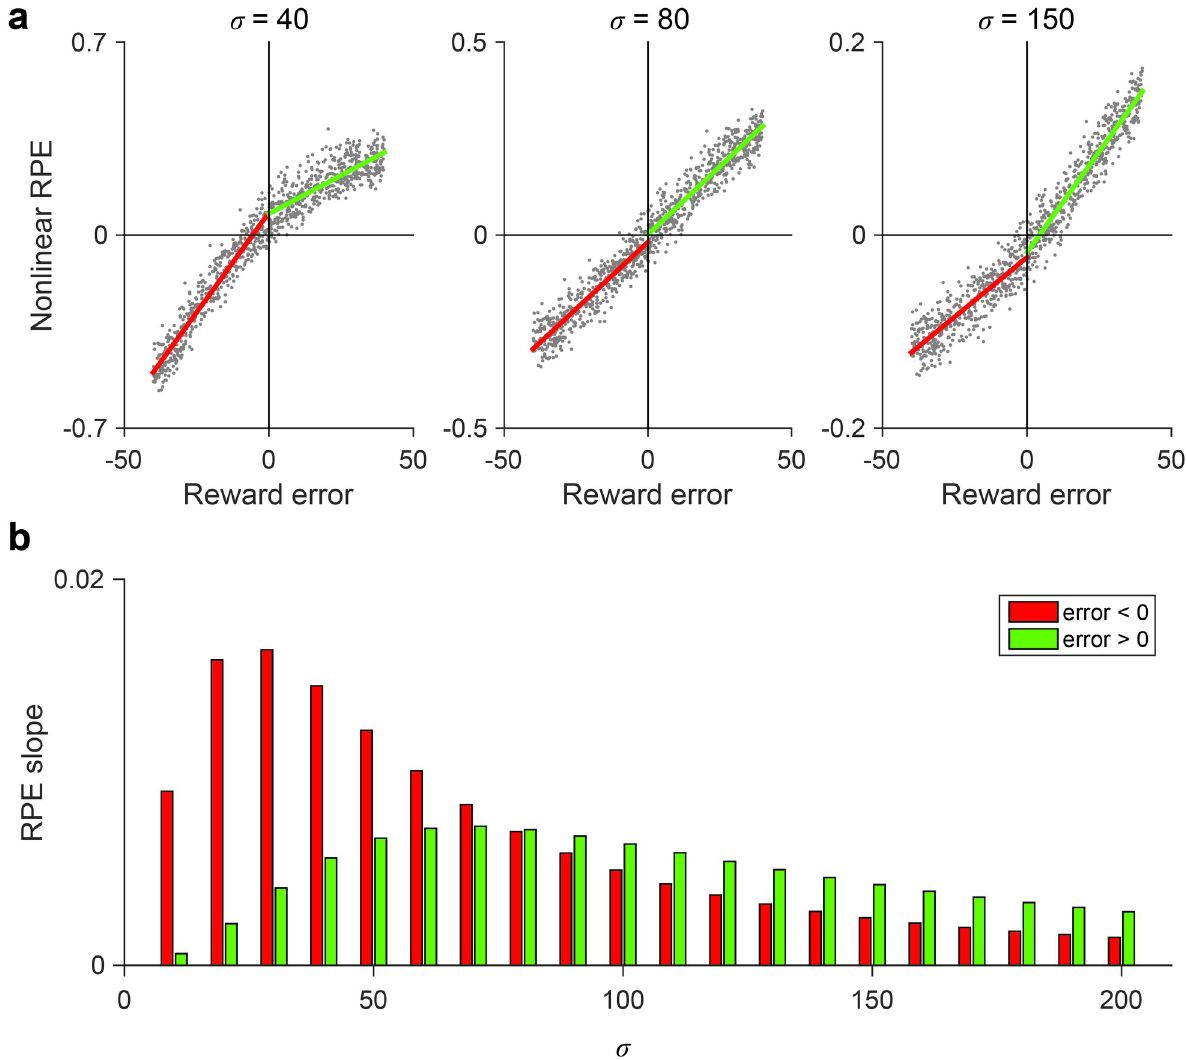
Fig 2. Parametric control of prediction error asymmetry. (a) Examples of variable reward prediction error (RPE) asymmetry. Each panel shows NRL responses for reward inputs ( R = 50 A.U.) with uniformly distributed noise. Lines show piecewise linear regression fits for negative (red) and positive (green) reward errors. (b) The NRL semisaturation term governs the degree and direction of RPE asymmetry. NRL RPE asymmetry is biased towards negative RPEs at low σ and postive RPEs at high σ